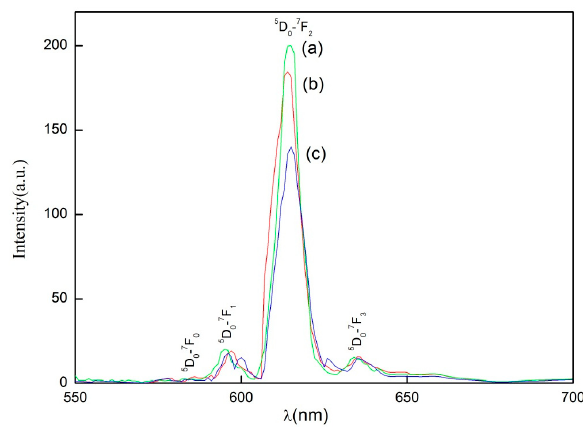
Figure 14. Photoluminescence spectra of ( c ) Y 2 O 3 :Eu annealed at 1400 ° C without sintering aids; ( b ) Y 2 O 3 :Eu annealed at 1400 ° C with sintering aids; and ( a ) the commercial red phosphor.